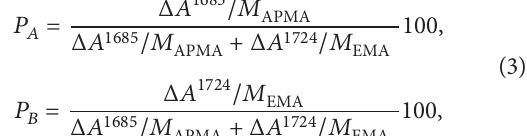
Figure 1. The chemical shifts assignments for the copolymers were based on the chemical shifts observed for the respective aromatic protons were shown between 8.00 and 7.28 ppm.